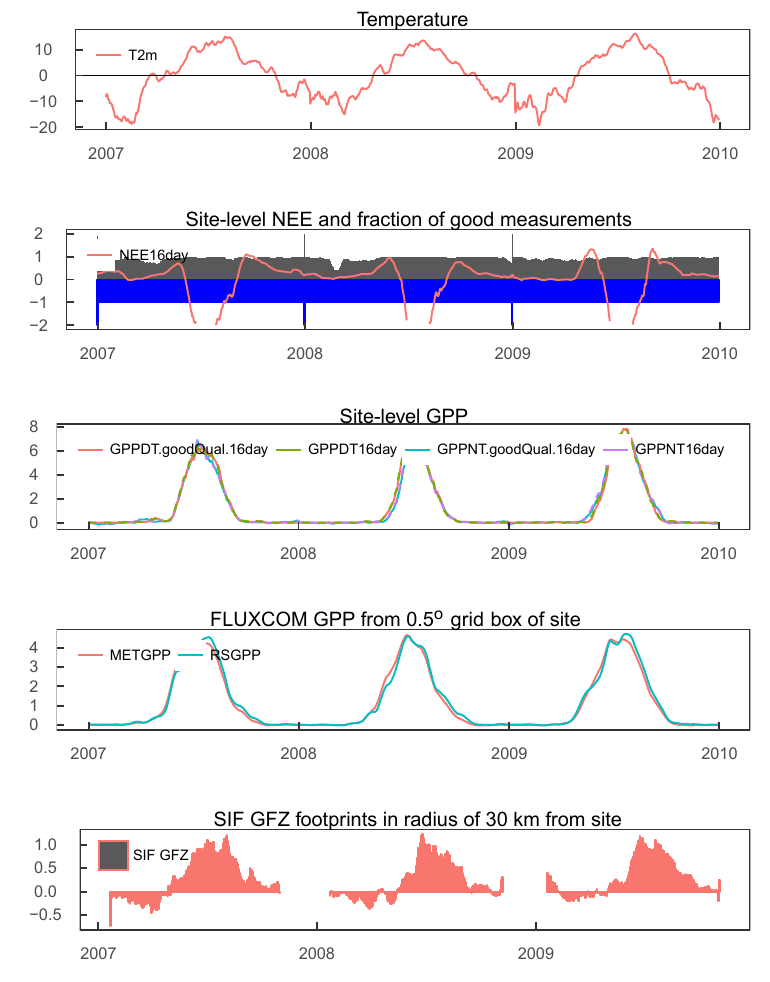
Figure A13. FI-Lom: Time series (16 day averages) of quality filtered air temperature and NEE; blue bars indicate fraction of available good quality temperature data and gray bars indicate fraction of good and gap-filled NEE data. The middle panel depicts the GPP derived from the night-time and daytime partitioning of NEE measurements, filtered for 80% of good quality and gap-filled NEE along with unfiltered measurements. The modelled GPP is taken from the 0.5 ◦ grid cell with centre coordinates closest to the tower. The bottom panel displays the 16 day averages of SIF GFZ footprints within 30km of the